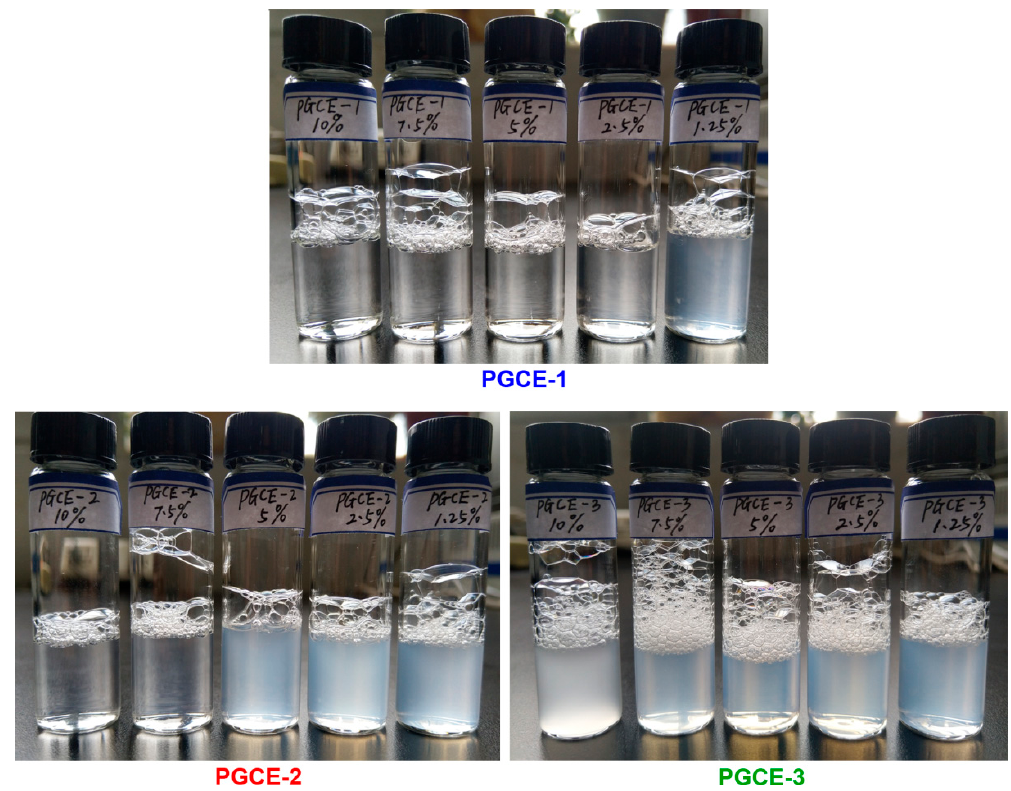
Figure 3. The appearance of polyglyceryl ‐ 10 caprylates in the water at different concentrations.